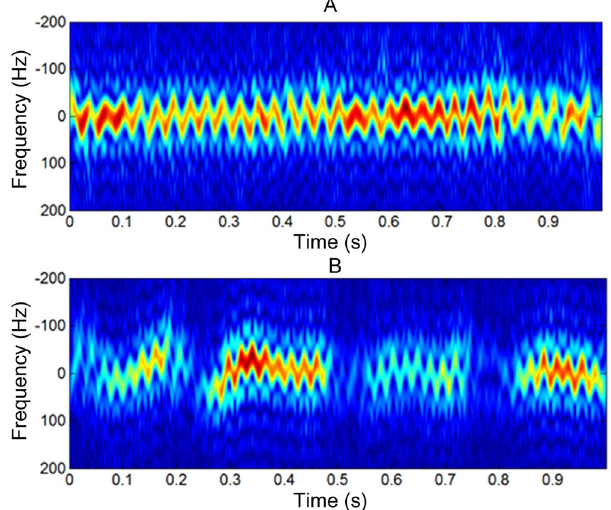
Figure 2. Examples of the time-frequency analysis by STFT: Time-frequency spectrograms of ( A ) Agrotis ypsilon and ( B ) Mamestra brassicae . The sliding window length is 200 ms with the frequency resolution of 5